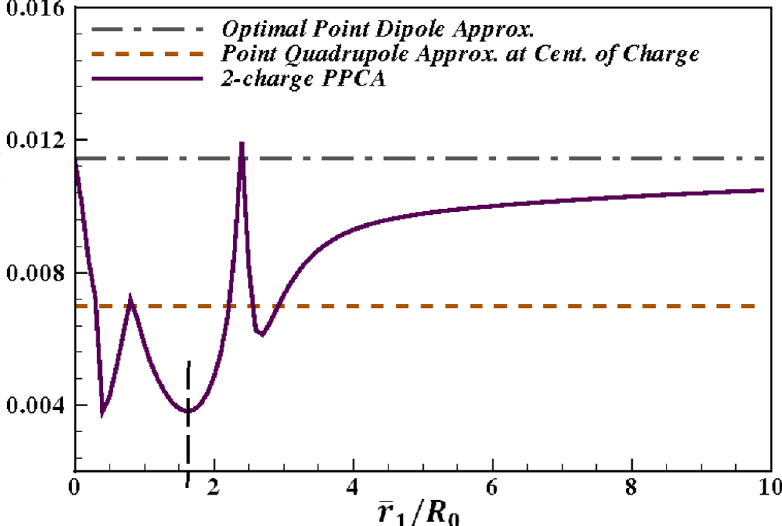
Figure 4. Accuracy of the 2-charge practical point charge approximation (PPCA) as a function of the distance (cid:2) rr 1 from the center of charge. For the sample charge distribution shown in figure 3. Accuracy is calculated as the RMS error, relative to the exact computation, at a distance of 2 R 0 , where R 0 is the maximum extent of the charge distribution from the center of geometry. The point dipole and point quadrupole approximations with center of charge as the center of expansion are shown for comparison. The vertical dashed line represents the value (cid:2) rr 1 & 1 : 6 R 0 that produces the lowest RMS error for the 2-charge PPCA in this case. Connecting lines are shown to guide the eye.